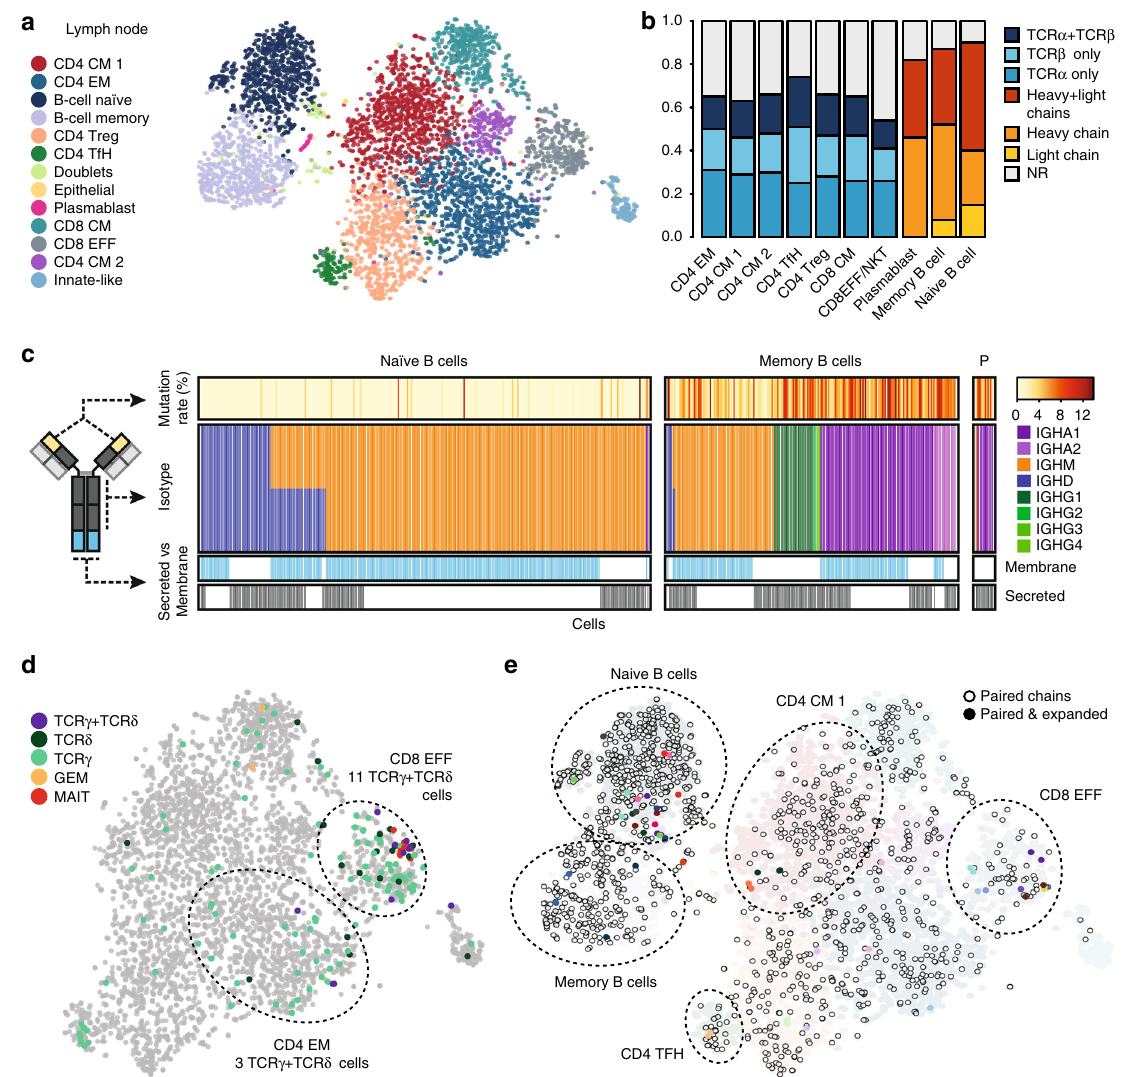
Fig. 5 RAGE-Seq on a human lymph node. a t-SNE analysis of 6027 lymph node cells generated from short-read sequencing data. Number of cells: B-cell naive, 853; B-cell memory, 738; CD4 effector memory (EM), 1069; CD4 central memory (CM) 1, 1069; CD4 CM 2, 226; CD4 T follicular helper cell (TfH), 142; CD4 T regulatory cell (Treg), 740; CD8 CM, 487; CD8 effector (EFF), 405; Plasmablast, 28; Innate-like, 144; Doublets, 86; Epithelial, 13. b Assignment of productive TCR and BCR chains to each population identi fi ed in a . NR, no receptor. c Characterization of full-length IGH mRNA sequences assigned to individual naïve ( n = 401) or memory B cells ( n = 283) from the lymph node or plasmablasts (P, n = 15) from a matched tumor (Supplementary Fig. 6). Mutation rate (%) measures the percentage of nucleotides in the V region mutated from germline. d Assignment of TCR γ chains, TCR δ chains and invariant TCR chains associated with MAIT and GEM T cells to the T-cell populations of the lymph node in a . 92 T cells were assigned TCR γ chains alone, 14 T cells were assigned TCR δ chains alone and 11 T cells were assigned paired TCR γ and TCR δ chains. 10 T cells were assigned MAIT-associated TCR chains and two T cells assigned GEM-associated TCR chains (see Methods). e Visualisation of the lymph node t-SNE plot in a for cells assigned paired BCR ( n = 689) or paired TCR ( n = 705) chains and amongst these cells those clones that are expanded. Clones were considered expanded if a paired TCR or BCR sequence was found in more than one cell. Different colors denote each expanded clone. 13 T-cell expanded clones and 13 B-cell expanded clones were identi fi ed. Each clone was represented by two abundant genes chosen from within each respective cell type cluster (Supplementary Fig. 5g). T cells and 215 B cells were identi fi ed (Supplementary Fig. 6a – c).